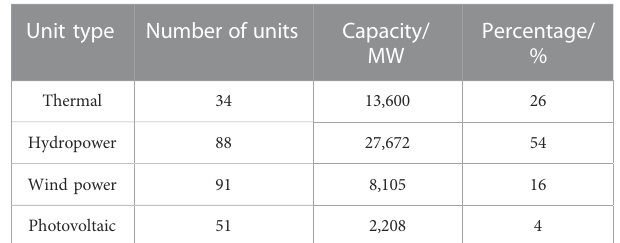
TABLE 1 The proportion of capacity of each type of